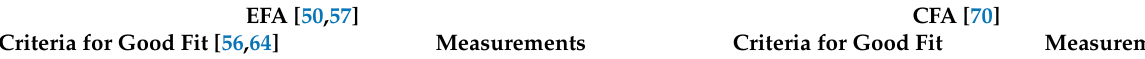
Table 5. Goodness-of-fit indices in EFA and CFA and